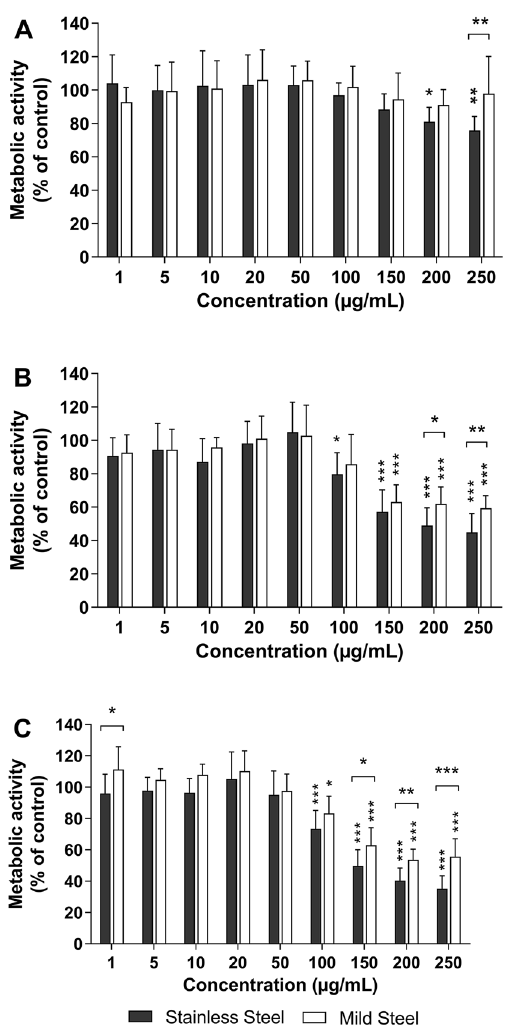
Figure 7. Cytotoxicity of welding particles in primary human small airway epithelial cells. Cells from three donors were exposed to stainless steel or mild steel welding particles (1–250 µg/mL) for 24 ( A ), 48 ( B ) and 72 ( C ) h. Cell viability was assessed using Alamar Blue assay and results are expressed as % metabolic activity compared to untreated cells. Results are presented as mean ± standard deviation of three independent experiments for each donor (n = 9). Statistically significant differences, as compared to the control are labelled with asterisks (* for P-value < 0.05, ** for P-value < 0.01, *** for P-value < 0.001). Figure created using GraphPad Prism version